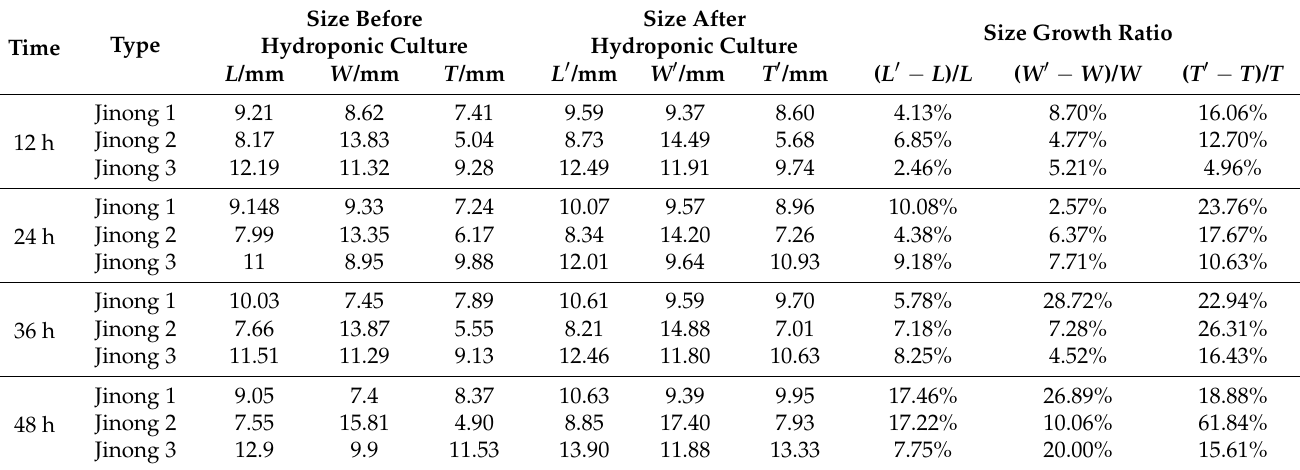
Table 2. The changes in tri-axial dimensions for the three varieties of the Cyperus esculentus seed before and after hydroponics.